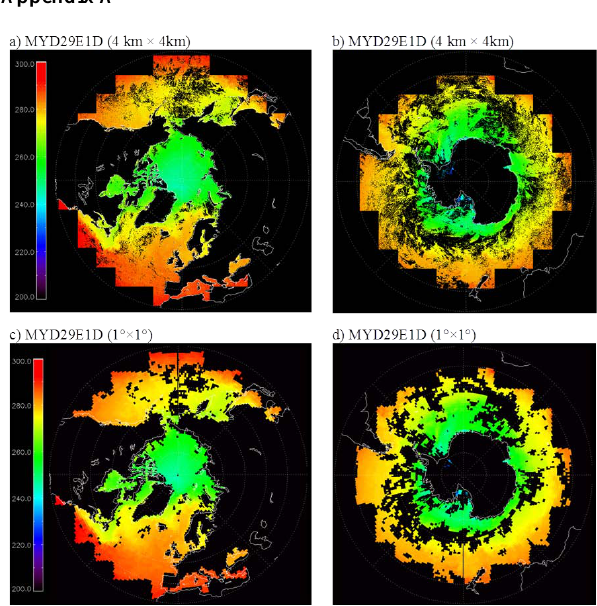
Fig. A1. 9-day composite surface skin temperatures (K) of MODIS/Aqua data (MYD29E1D; T skin (MODIS ICE)) over the (a) Northern Hemisphere during the days 106–114, 2003, and (b) Southern Hemisphere during the days 258–266, 2003 (http://modis-snow-ice.gsfc.nasa.gov/?c=MOD29E1D). The temperature is called ice surface temperature (IST) in the reference. The MYD29E1D data at ∼ 4km × 4km spatial resolution have been reconstructed to 1 ◦ × 1 ◦ bin for the comparison with AIRS/AMSU data. (c) Same as Fig. A1a and (d) same as Fig. A1b, except for the spatial resolution of 1 ◦ × 1 ◦ .